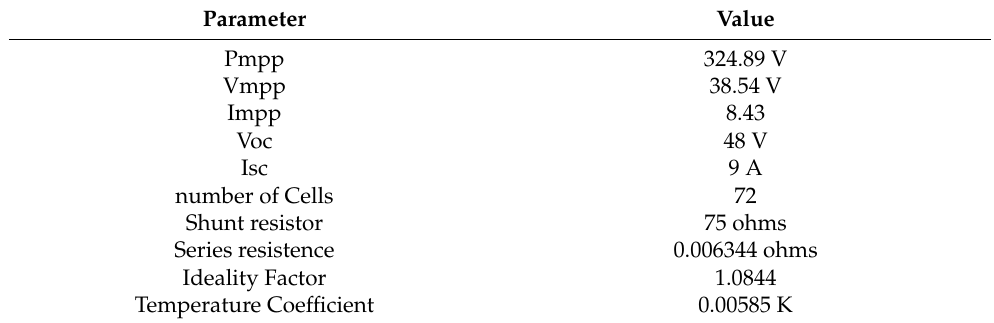
Table 3. Photovoltaic parameters.